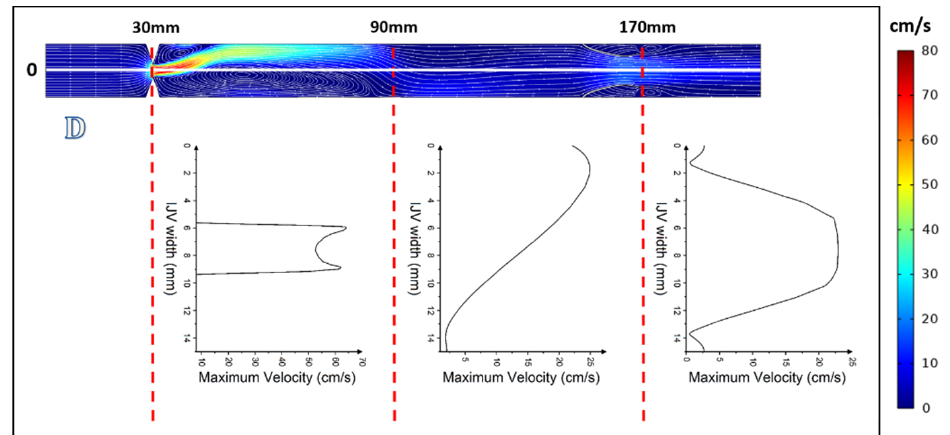
Figure 4. Models of the internal jugular vein and symmetric 2-leaflets valve with velocity profiles at t = 0.25 s: ( A ) without upstream stenosis; ( B ) with 30% upstream stenosis; ( C ) with 60% upstream stenosis; and ( D ) with 75% upstream stenosis.